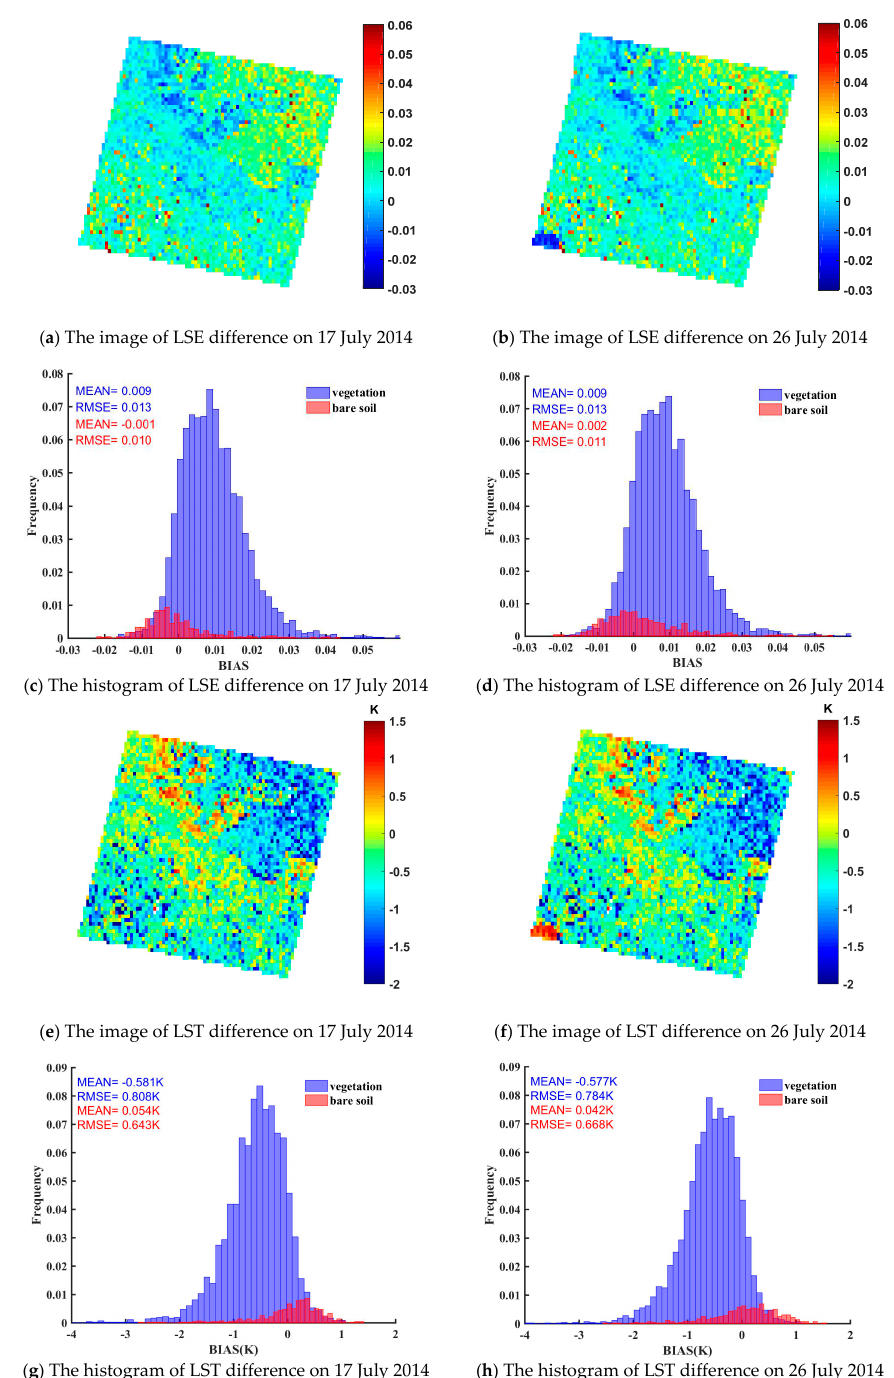
Figure 8. The images and histograms of LSE difference between the AST_05 product and the new method on 17 and 26 July 2014; the corresponding images and histograms of LST difference. ( a ) The image of LSE difference on 17 July 2014; ( b ) The image of LSE difference on 26 July 2014; ( c ) The histogram of LSE difference on 17 July 2014; ( d ) The histogram of LSE difference on 26 July 2014; ( e ) The image of LST difference on 17 July 2014; ( f ) The image of LST difference on 26 July 2014; ( g ) The histogram of LST difference on 17 July 2014; ( h ) The histogram of LST difference on 26 July 2014.